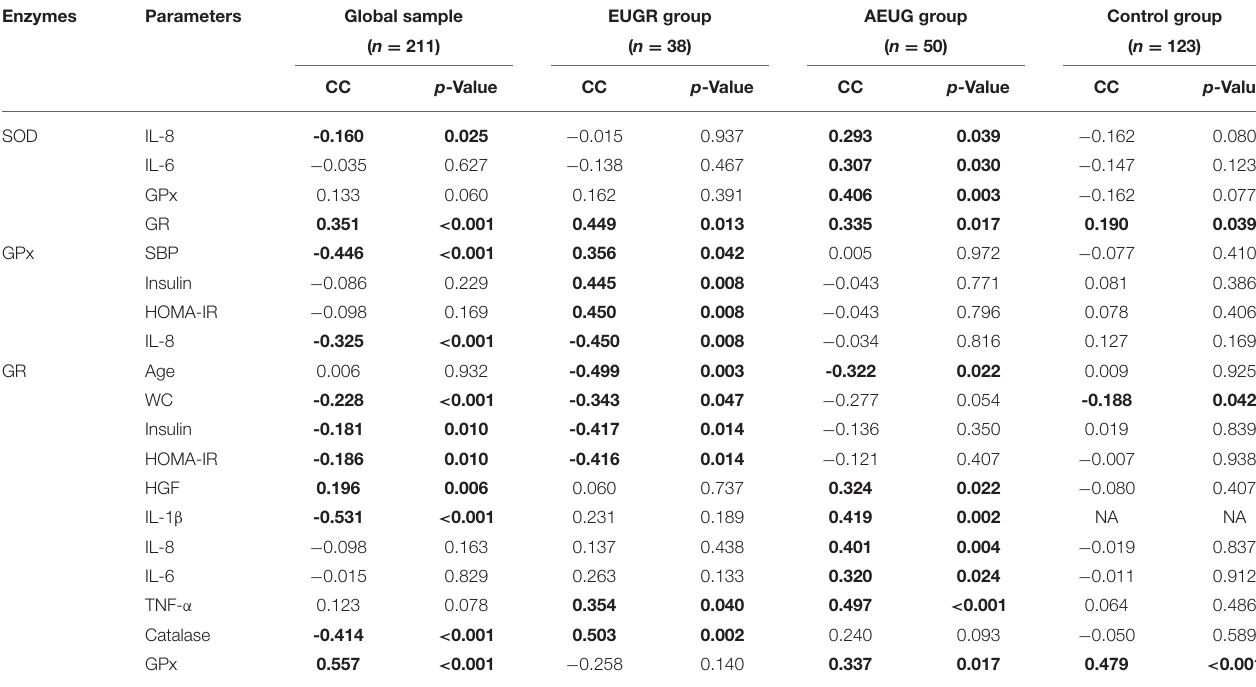
TABLE 4 | Selected significant relationships among erythrocyte antioxidant enzymes activities and anthropometric, blood pressure, and biochemical parameters in the global sample and those in prepubertal children with a history of prematurity and extrauterine growth restriction (EUGR group), prematurity with adequate extrauterine growth (AEUG group), and healthy children (control